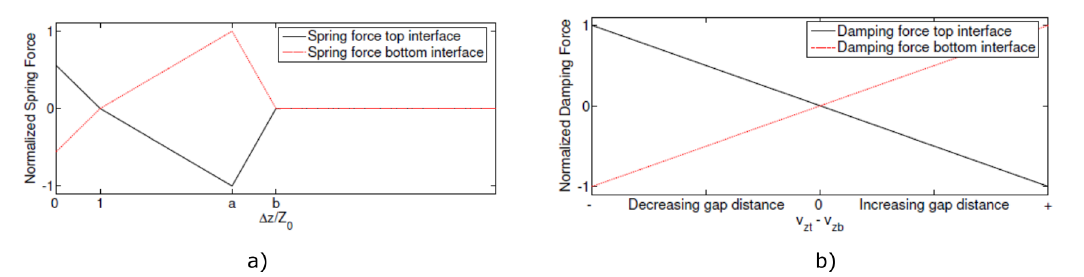
Figure 5. ( a ) Spring forces F st and F sb and ( b ) damping forces F dt and F db at the simulated delamination as a function of the gap distance ∆ Z